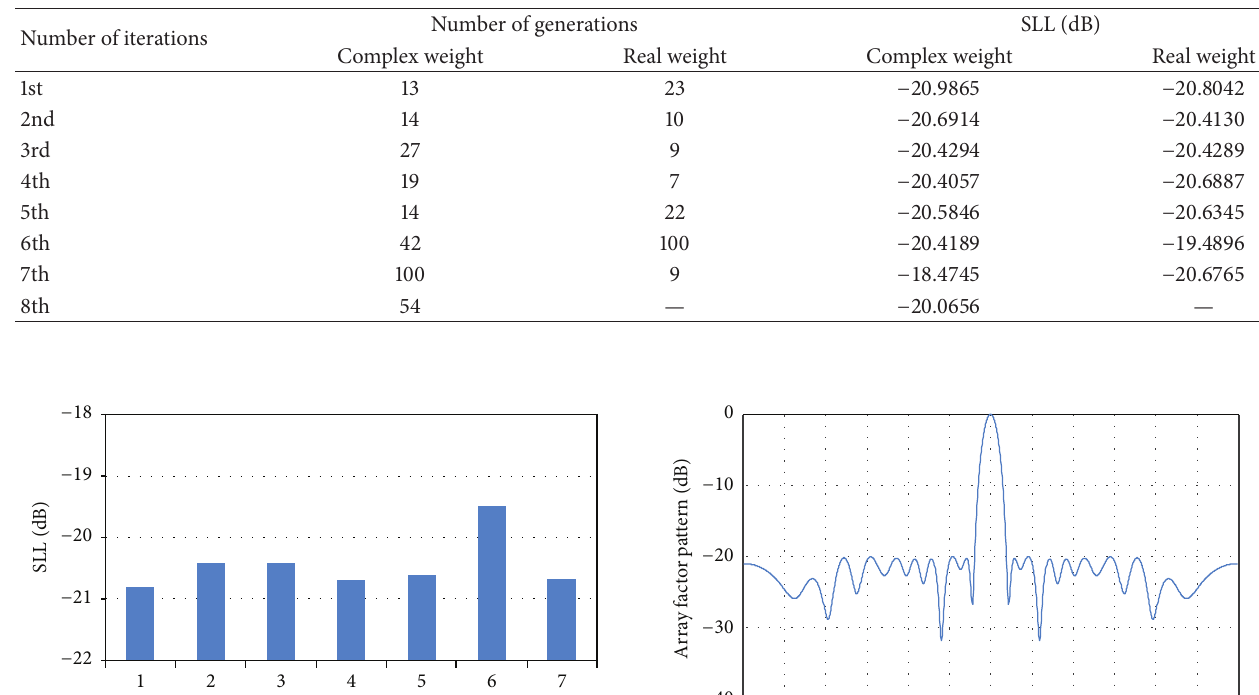
Table 2: Results of iterative process.